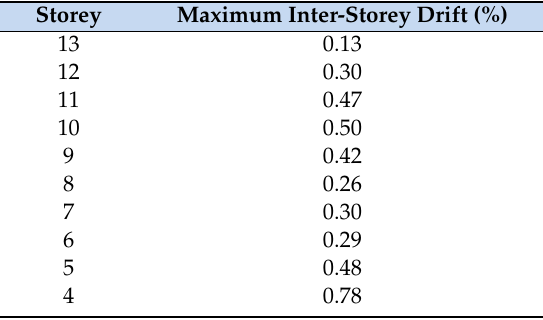
Table 6. Maximum inter-storey drift for whole building with slab using THC for the ULS case. Storey